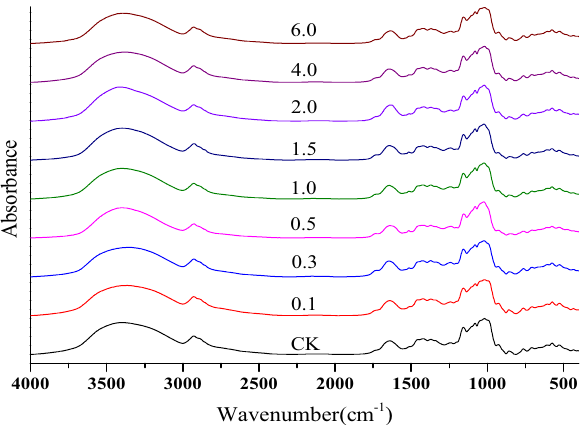
Figure 2. FTIR spectra of cultivated M. oleifera roots with Na 2 SeO 3 concentration of 0, 0.1, 0.3, 0.5, 1.0, 1.5, 2.0, 4.0 and 6.0 mg/kg.